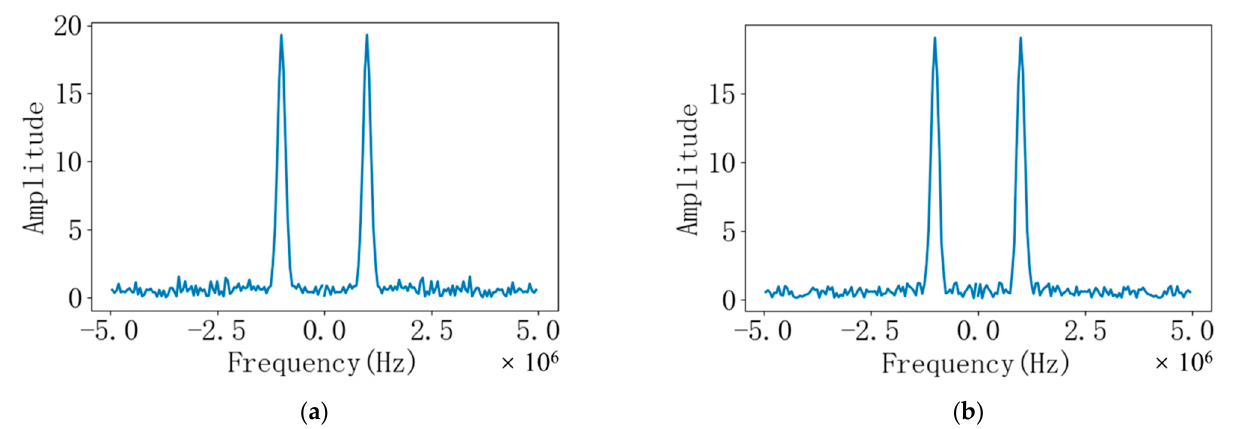
Figure 7. ( a ) Bilateral spectrogram of the downstream echo signal before filtering; ( b ) Bilateral spectrogram of the countercurrent echo signal before filtering.